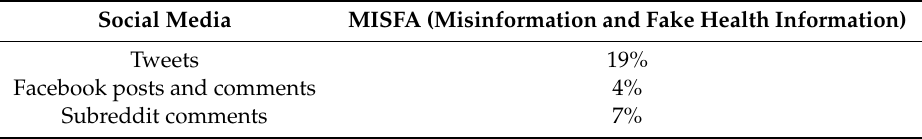
Table 6. Percentage of MISFA for each social media channel